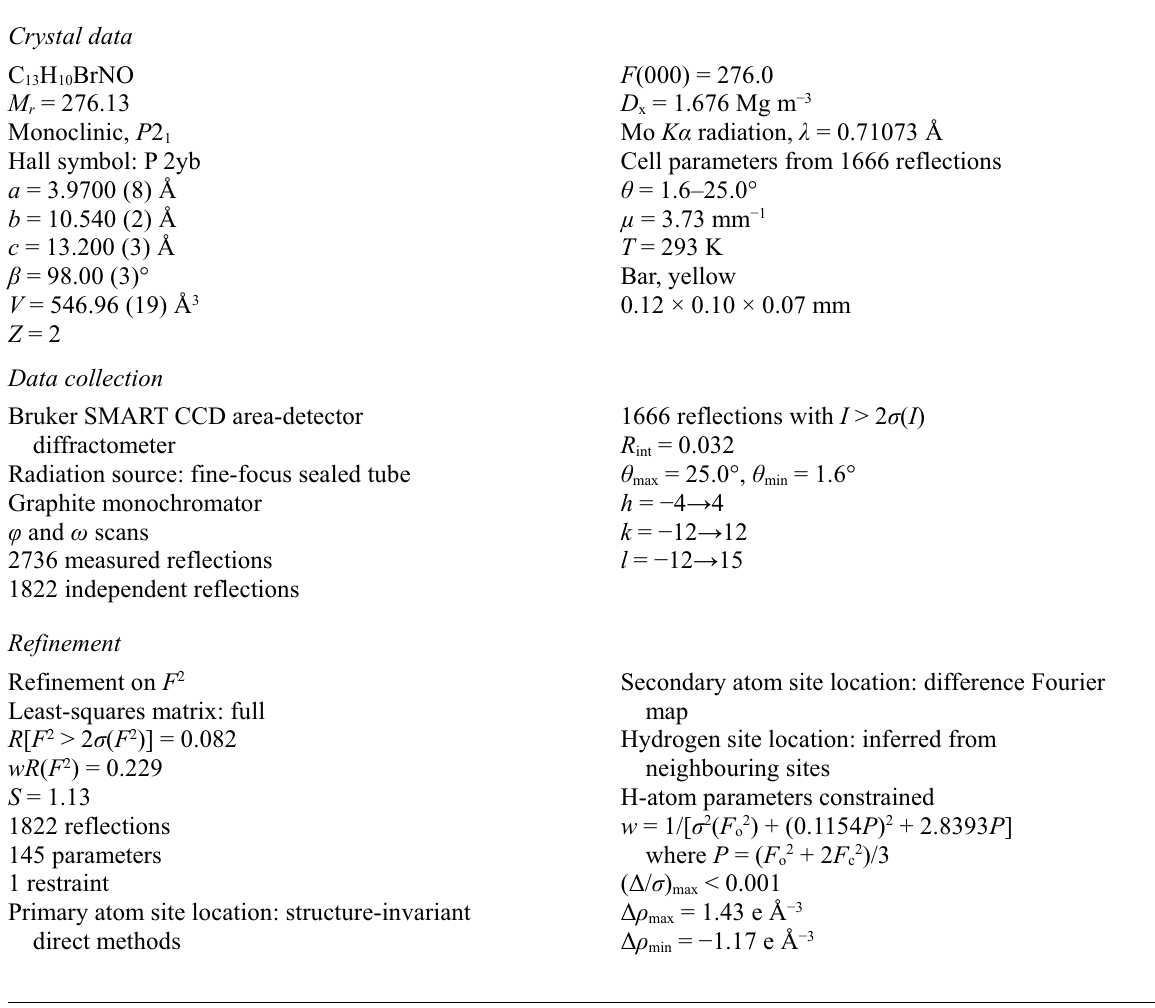
Figure 2 A view of the packing and the intramolecular hydrogen bonding (dashed lines) of (I) in the unitcell.